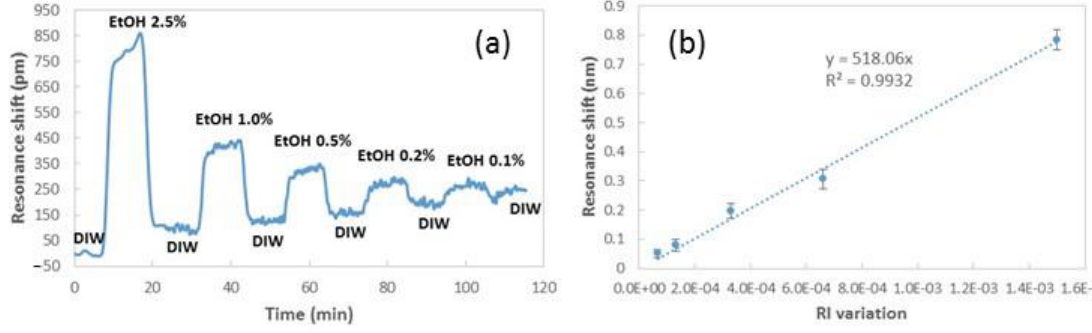
Figure 11. ( a ) Temporal evolution of the spectrum shift measured for a PA6 NFs sensing layer in real-time. ( b ) Sensitivity curve of three different sensing tests realized with different NFs layers. The average sensitivity achieved was close to 518 nm / RIU in the visible range of the